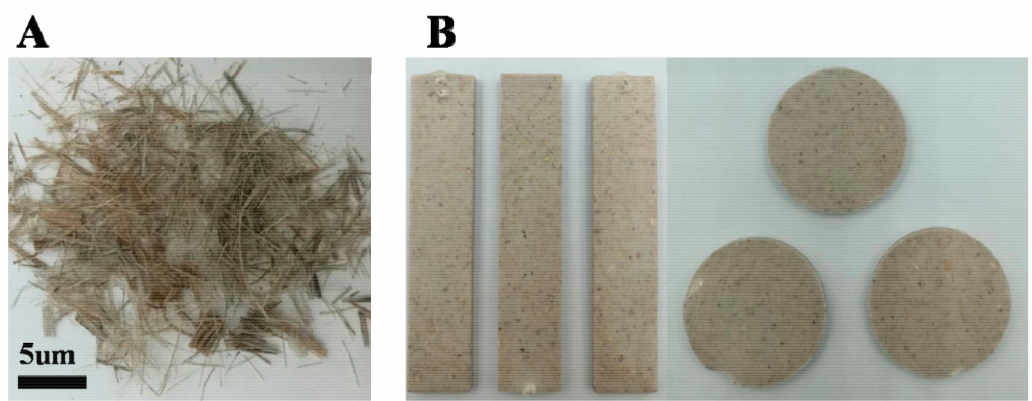
Figure 2. ( A ) Short abutilon fibers and ( B ) composite coupons for thermomechanical analysis.